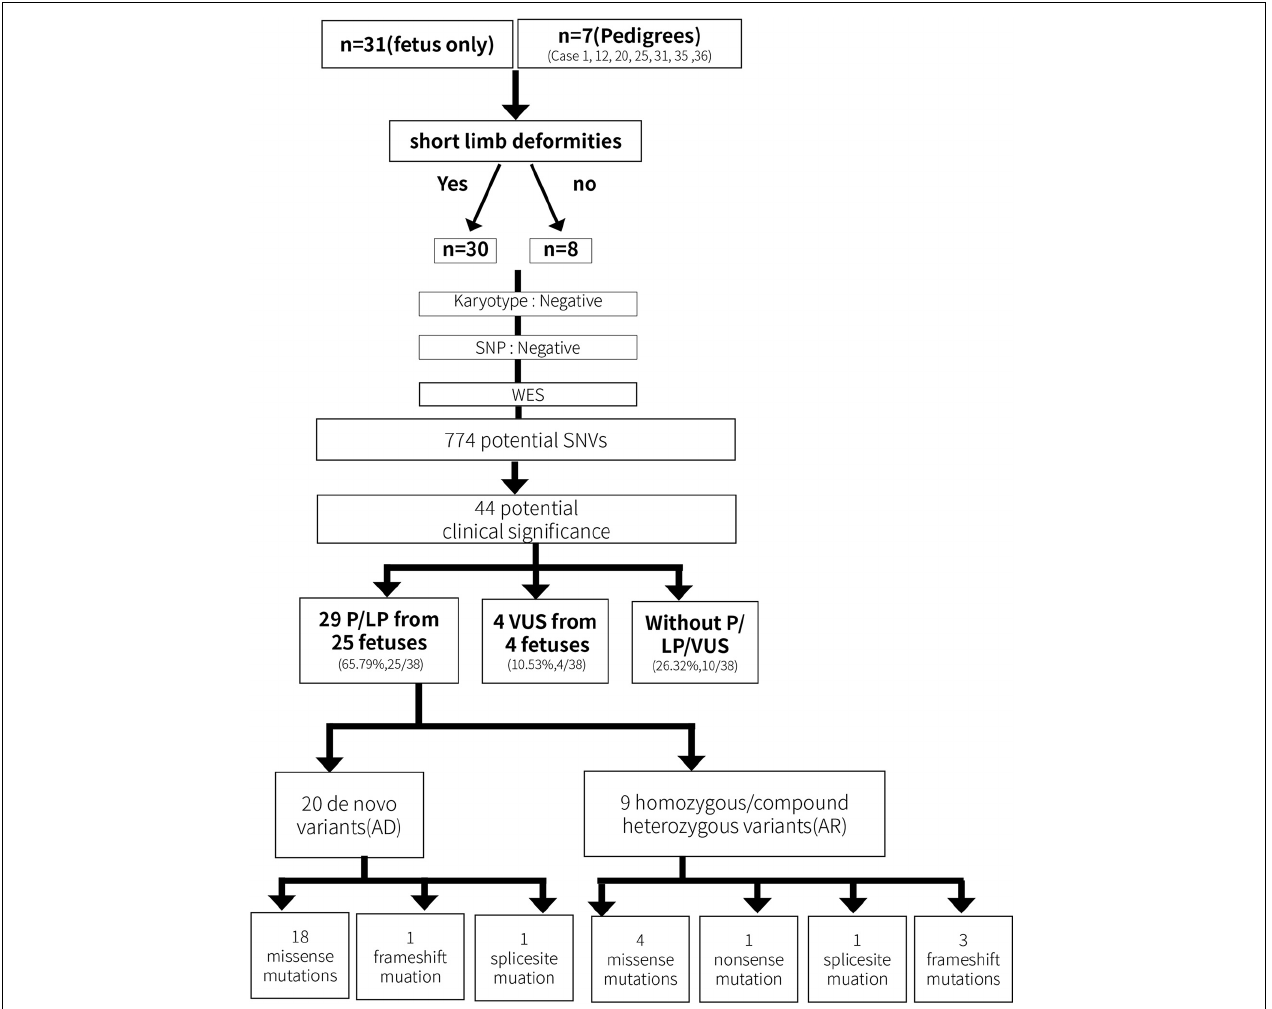
FIGURE 2 | The overall experimental workflow for identifying genetic variations in the present